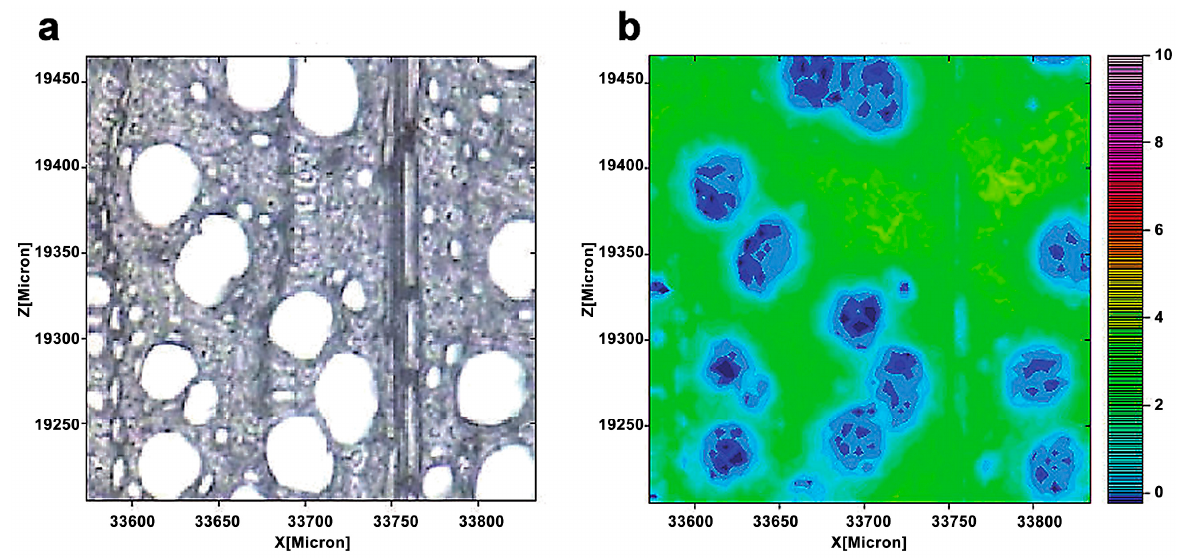
Figure 3. A light microscopic image of a cross-section of a beech ( a ). The cellulose distribution was seen by combining the spectra images for the wavenumber range 1390–1350 cm − 1 ( b ). From blue (low) to pink (high), the color scale denotes increasing cellulose concentration.